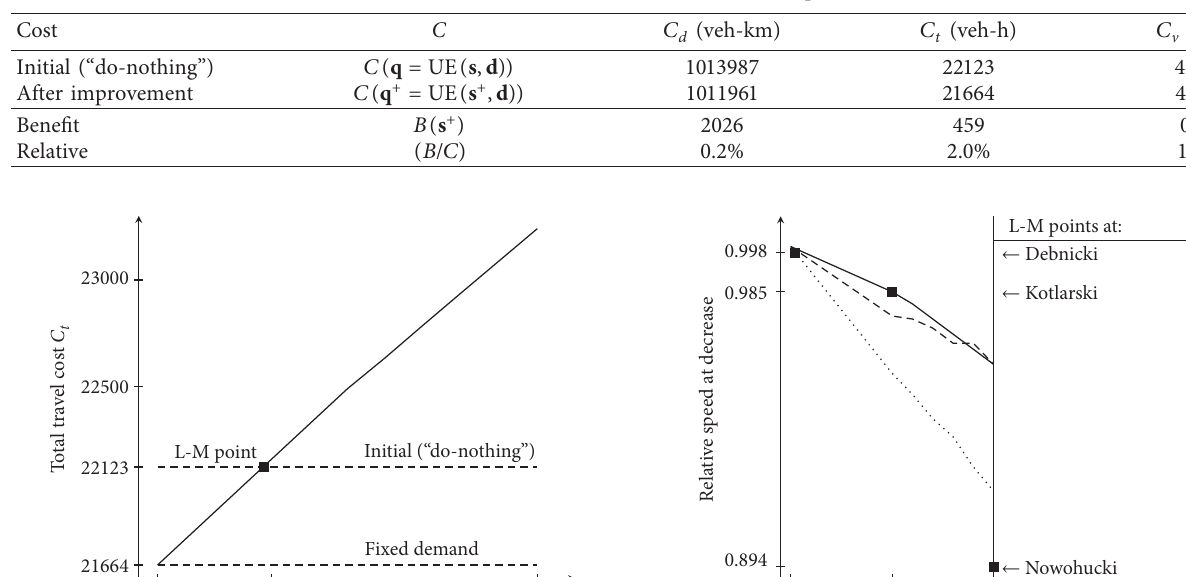
Figure 2: Fixed-demand traffic flows after eastern expressway (S7) in Krakow is opened (new arcs marked with solid black; bars denote morning peak flow). Table 1: Fixed-demand benefits of the road network improvement scheme.